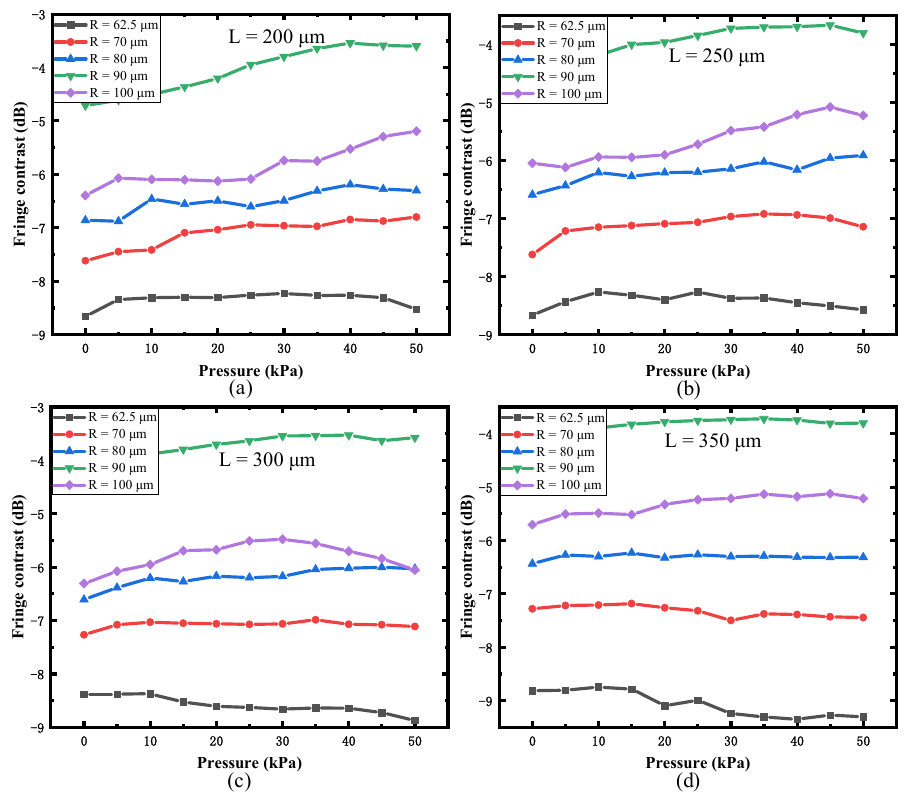
Figure 9. Relationship between the fringe contrast and applied pressure under different initial cavity lengths: ( a ) L = 200 µ m, ( b ) L = 250 µ m, ( c ) L = 300 µ m, and ( d ) L = 350 µ m.